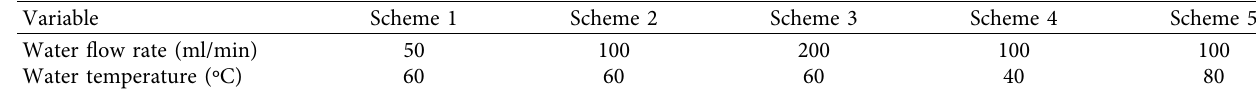
Figure 6: Initial conditions of airflow before trickling. Table 3: Experimental